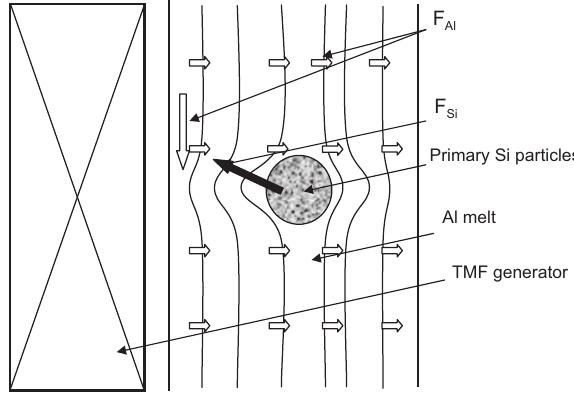
Figure 4 Effect of the TMF on the thickness of the enriched pri- mary Si particles layer in the Al-22.9 wt. % Si alloy solidifi ed from 1023 K at a cooling rate of 30 K/min.